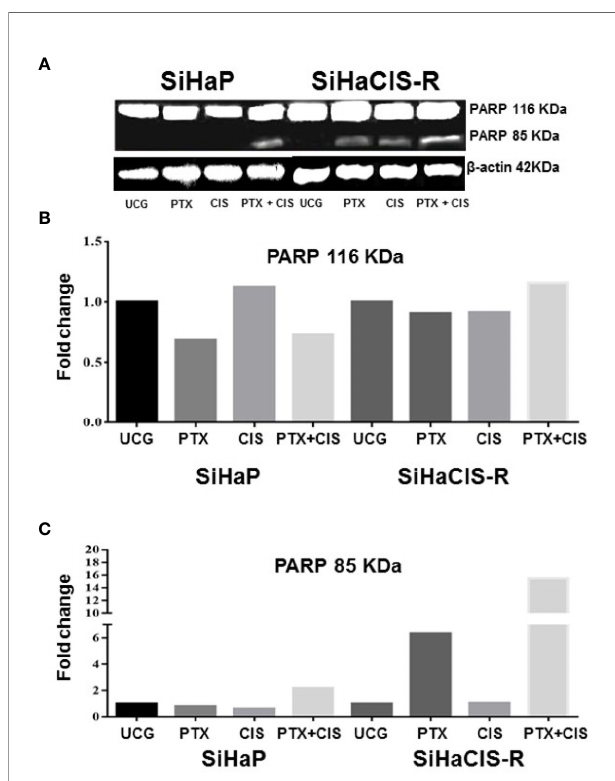
FIGURE 3 | PTX in combination with CIS increased PARP-1 cleavage in chemoresistant SiHa cells. Western blot analysis of PARP-1 in SiHaP and SiHaCIS-R cells were treated with CIS (30 m M), PTX (4 mM), or PTX + CIS for 24 h. Then, PARP cleavage was evaluated by Western blot (A) . Densitometric analysis of total PARP-1 (B) and the cleavage of PARP (C) are shown. Relative density was calculated using Image Studio Lite ver. 5.2.5 (LI-COR Biotechnology) software. A representative example of three assays performed in triplicate is shown. b -Actin was used as a loading control. UCG, Untreated Control Group; CIS, CISplatin; PTX,